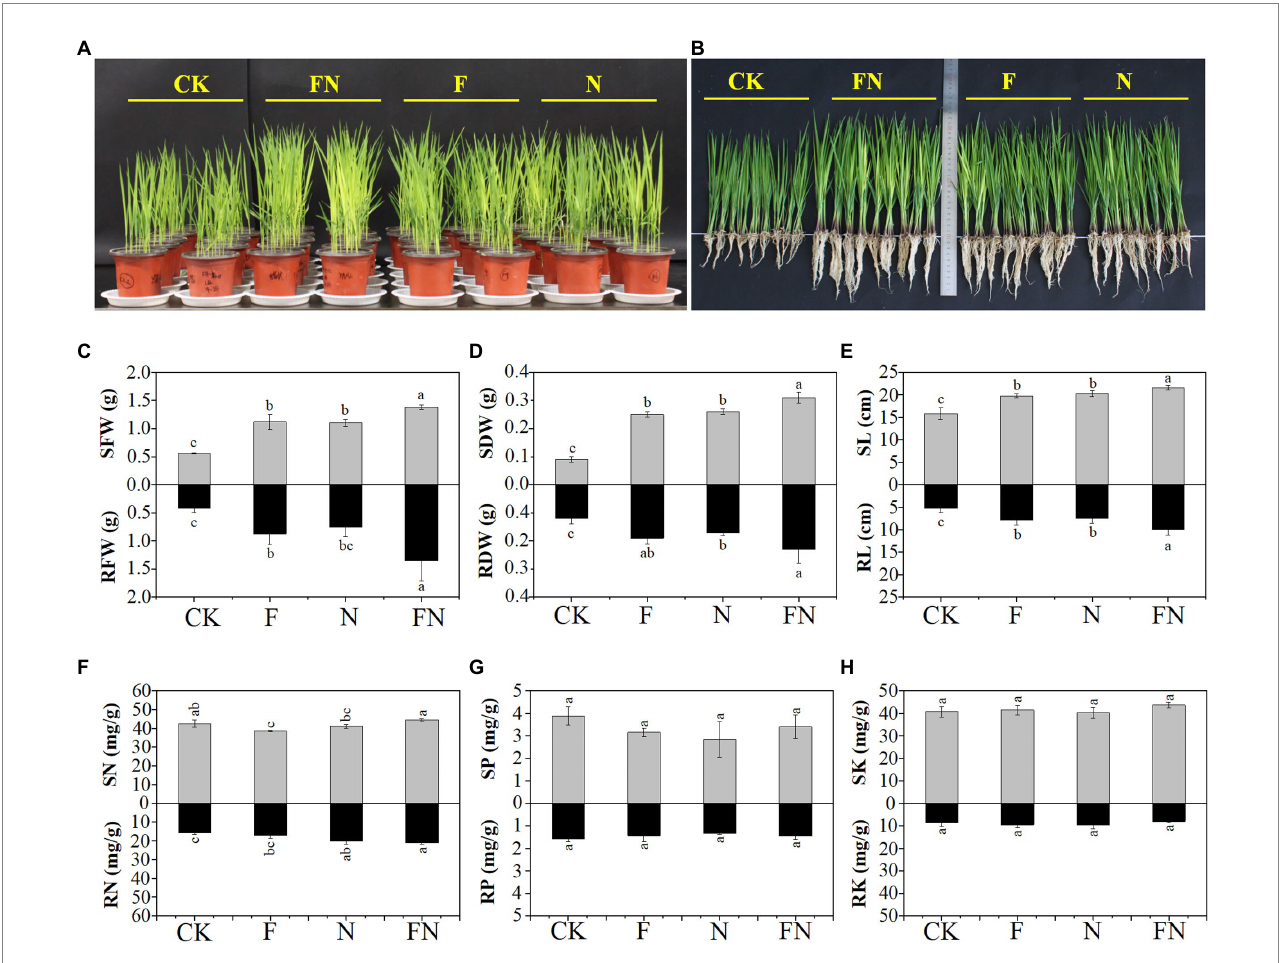
FIGURE 1 The effects of different microbial inoculants on rice. (A) The rice pot experiments; (B) photos showing 16-day-old rice plants; (C) rice shoot (S) and root (R) fresh weight (FW); (D) rice shoot (S) and root (R) dry weight (DW); (E) rice shoot (S) and root (R) length (L); (F) Rice shoot (S) and root (R) nitrogen concentration (N); (G) rice shoot (S) and root (R) phosphorus concentration (P); (H) rice shoot (S) and root (R) potassium concentration (K); CK, non- inoculated; F, inoculated with Bacillus velezensis FH-1; N, inoculated with Brevundimonas diminuta NYM-3; FN, inoculated with B. velezensis FH-1 and B. diminuta NYM-3. Data followed by the different lowercase letters are significantly different at p ≤